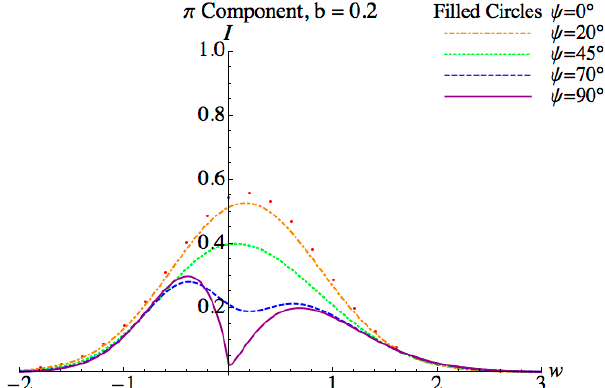
Figure 6. Lorentz–Doppler profiles of π -components of highly-excited hydrogen/deuterium spectral lines calculated by Equations (6.6) and (6.7), for the scaled magnetic field b = 0.2 (defined in Equation (6.1)) at five different values of the angle of observation ψ with respect to the magnetic field [66].